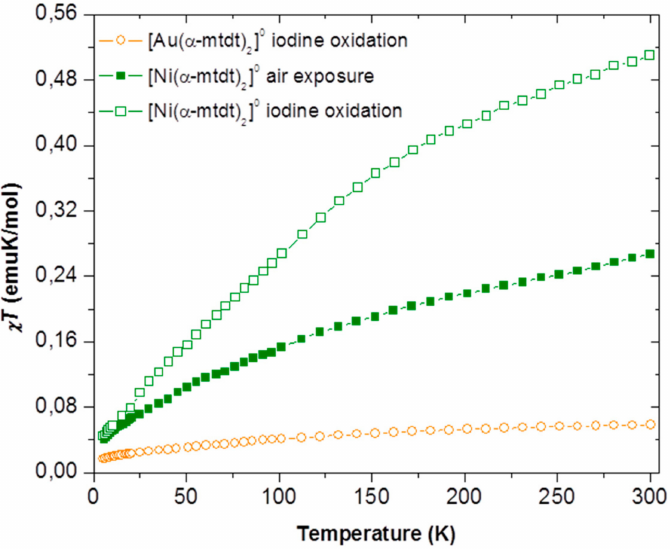
Figure 9. Temperature dependence of the χ T product for [M( α -mtdt) 2 ] (M = Au ( 6 ) and Ni ( 7 )) as a function of the absolute temperature T